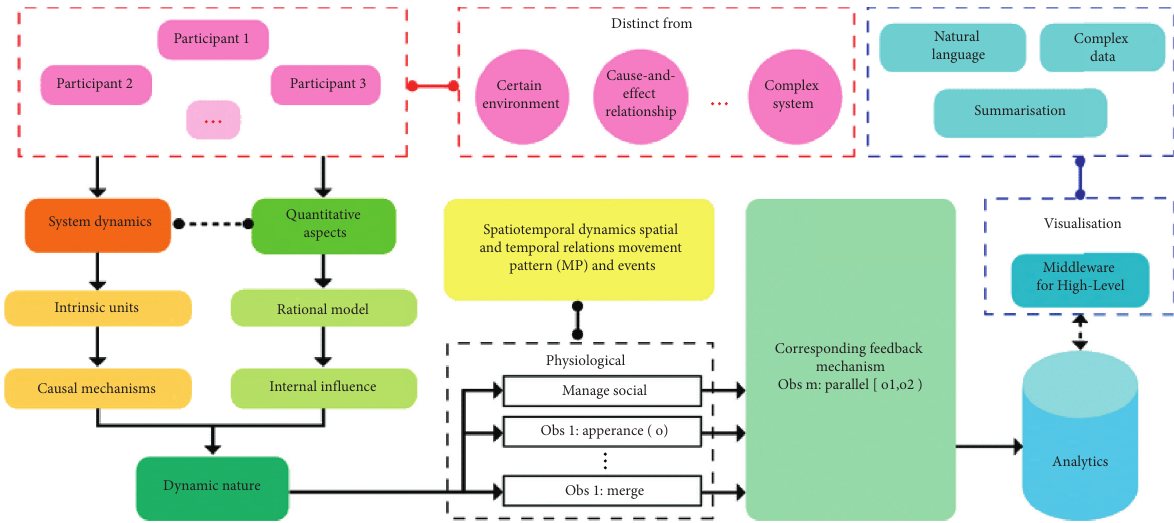
Figure 1: Dynamic planning game analysis